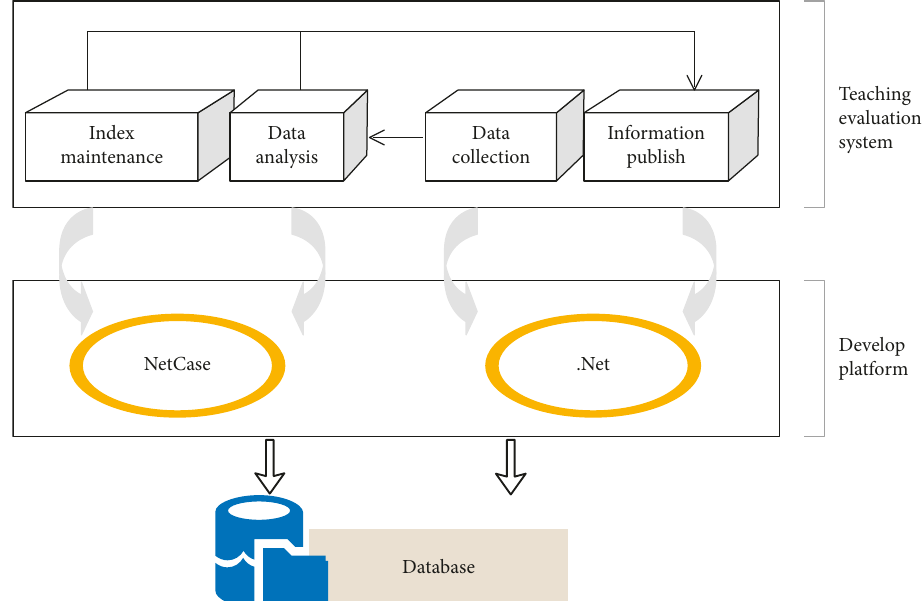
Figure 6: The overall framework of the